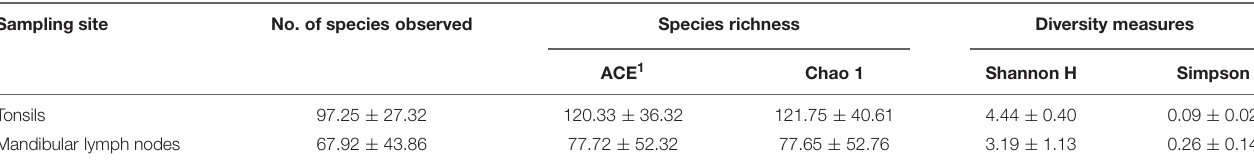
TABLE 1 | Species richness and diversity measures of tonsils and mandibular lymph nodes (MLNs). Mean values ± standard deviation are listed. Sampling